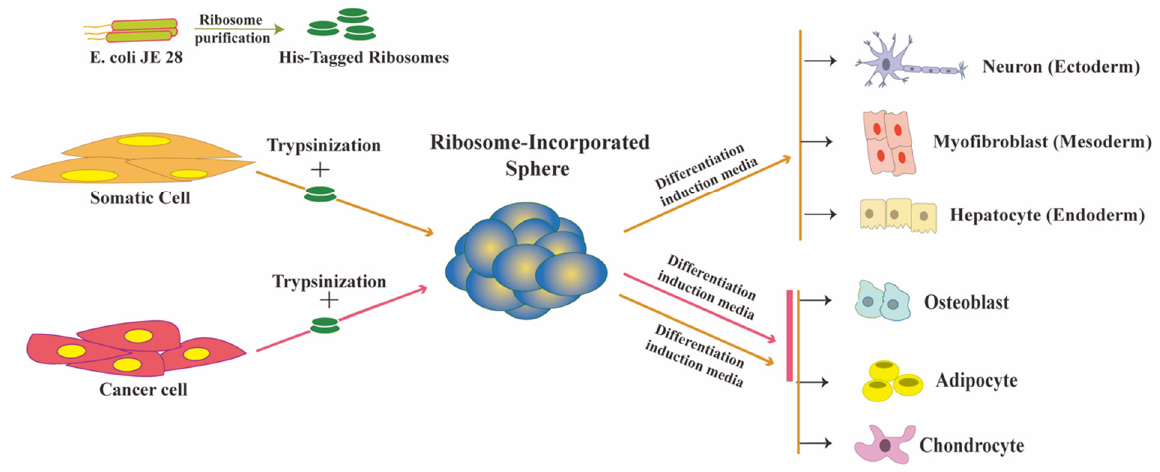
Figure 1. Ribosome incorporation leads to multipotency in somatic and cancer cells. Surprisingly, ribosomes from various prokaryotic (Gram-positive and Gram-nega- tive bacteria) and eukaryotic (yeast, mouse, and human) sources showed the sphere-form- ing effect on HDFs, suggesting a shared ribosomal element is involved in the mechanism.